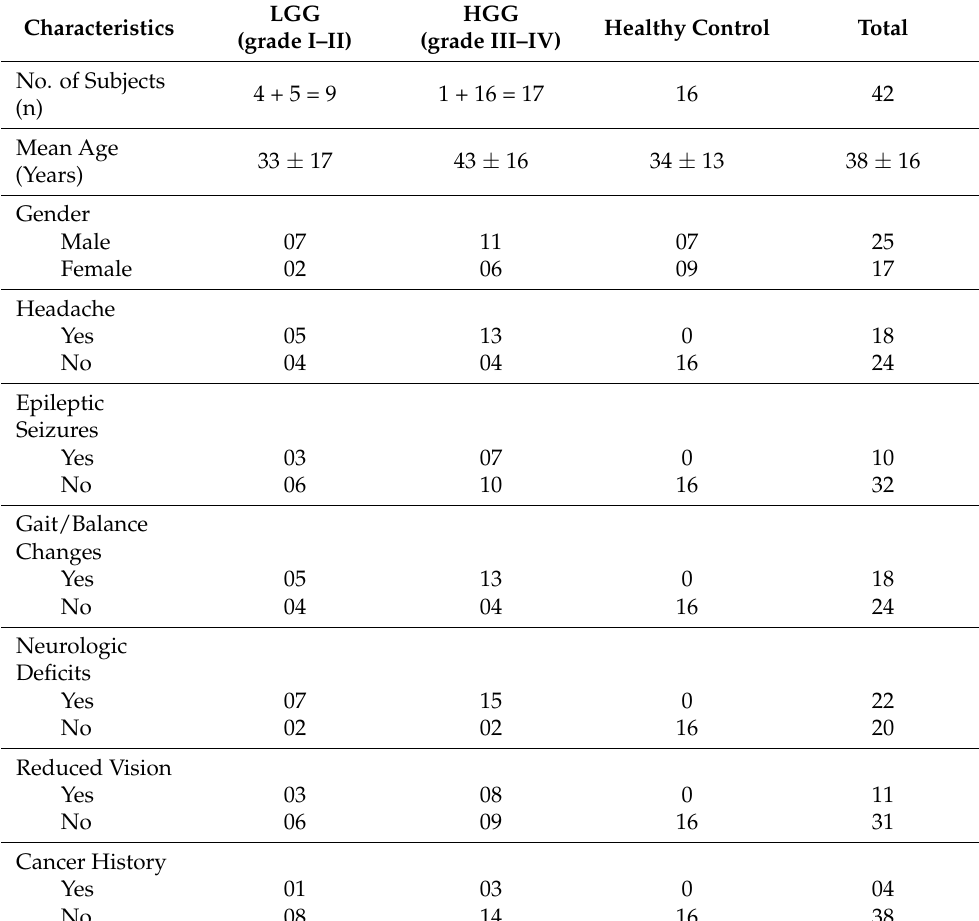
Table 1. Demographics and clinical characteristics of study